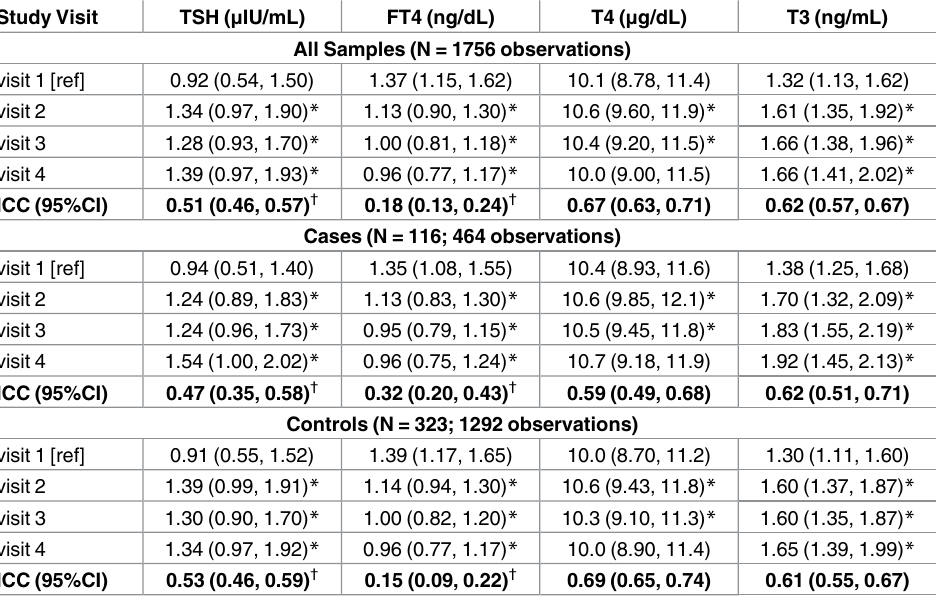
Table 2. Median (25th-75th) concentrations and intraclass correlation coefficient (ICCs) of thyroid hormone parameters by case-control status and study visit of sample collection. Study Visit TSH ( μ